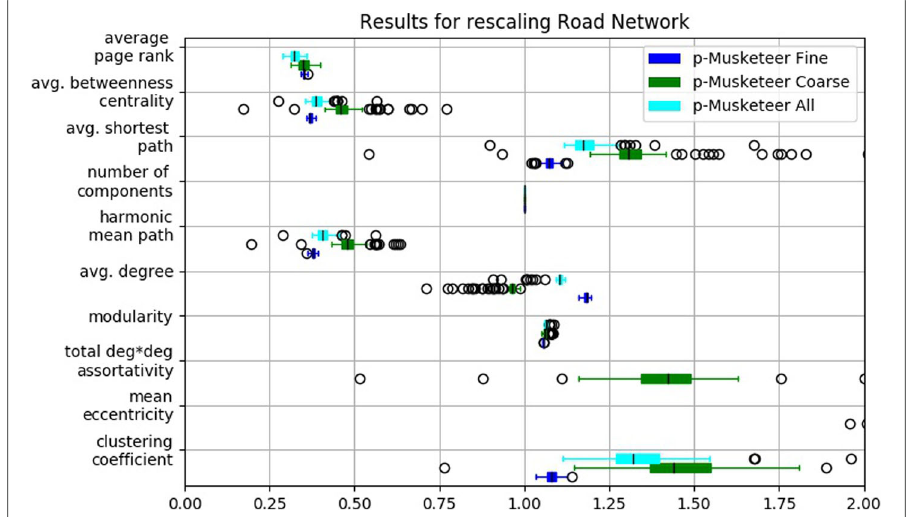
Fig. 20 Computational results for power grid graph opsahl-powergrid with 4941 nodes and 6211 edges rescaled to at least 16500 nodes and 27000